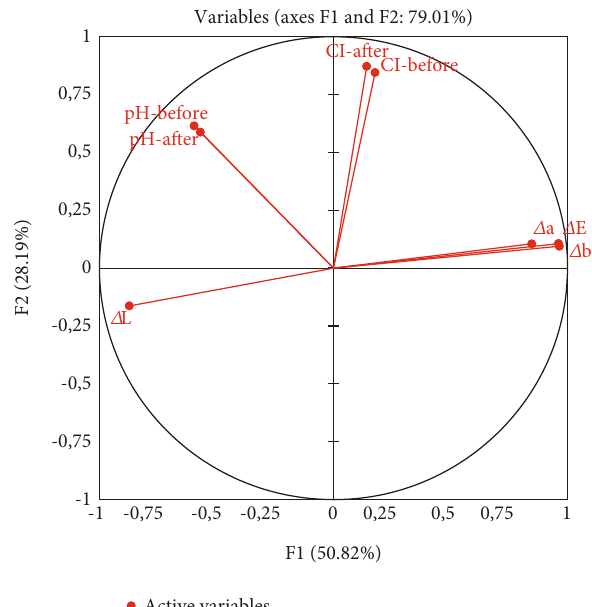
Figure 5: The projections of variables over the